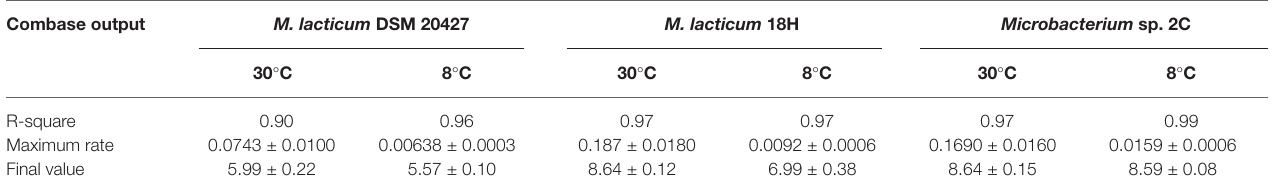
TABLE 2 | Summary of the recorded data obtained by Combase: the maximum growth rate (Log cfu/ml/h), the final value (Log cfu/ml), and the goodness of the fit data (R-square). Combase